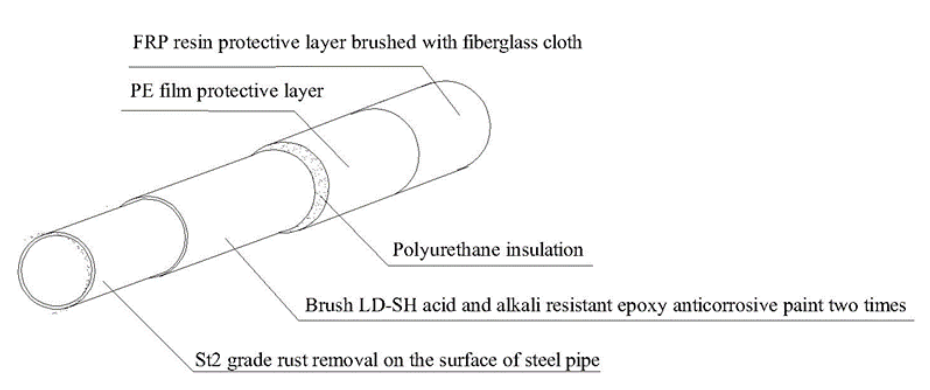
Fig. 3 Schematic diagram of polyurethane made insulation